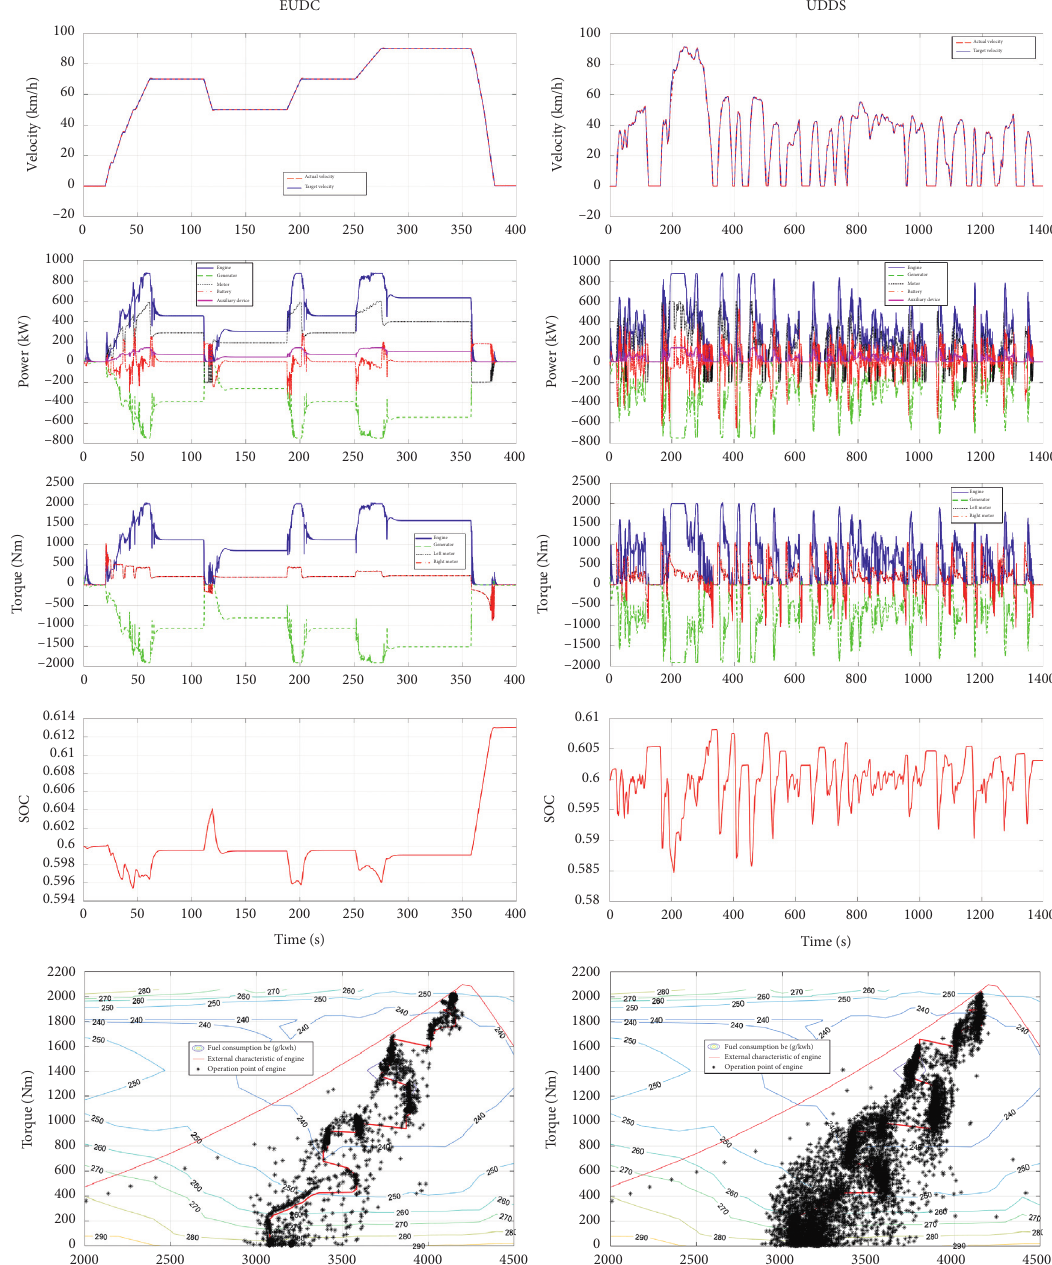
Figure 12: Simulation results of the EMS under EUDC and UDDS driving